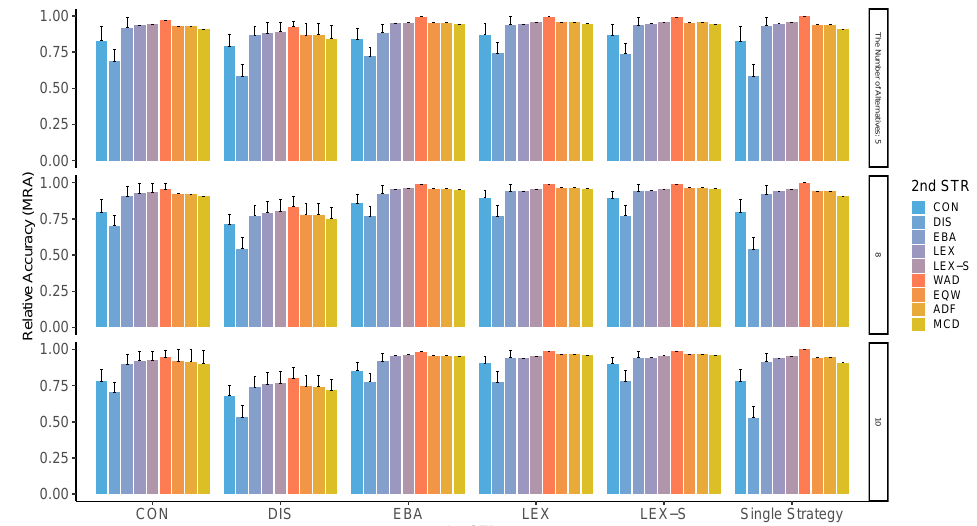
Figure A6. MRA in two-stage decision-making when three alternatives are left in the second stage. Note: ADF: additive difference; CON: conjunctive; DIS: disjunctive; EBA: elimination by aspects; EQW: equal-weighted strategy; LEX: lexicographic; LEX-S: lexicographic semi-order; MCD: majority of confirming dimensions; STR: strategy; WAD: weighted additive.